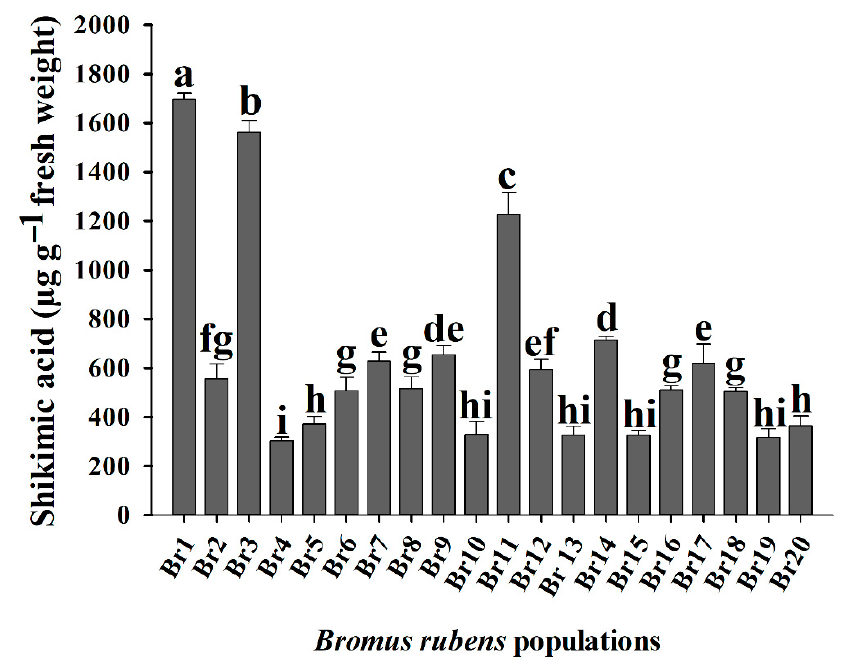
Figure 2. Shikimic acid accumulation of 20 Bromus rubens populations at 1000 µM glyphosate. The different letters in the measurements differed statistically in the Tukey’s test (95%).